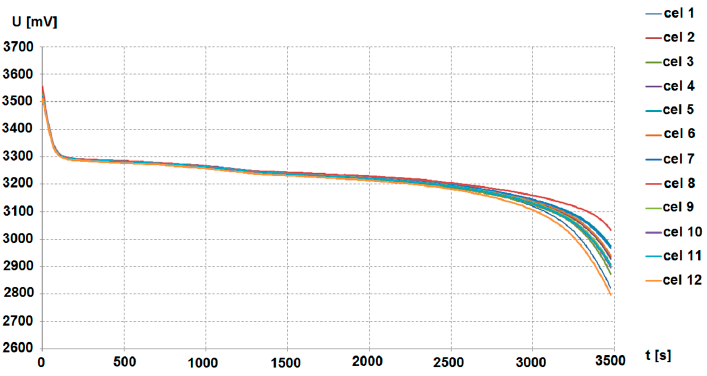
Figure 8. Example of discharge characteristics of the propulsion battery after 1.5 years of use. Discharge current: 2.3 A.